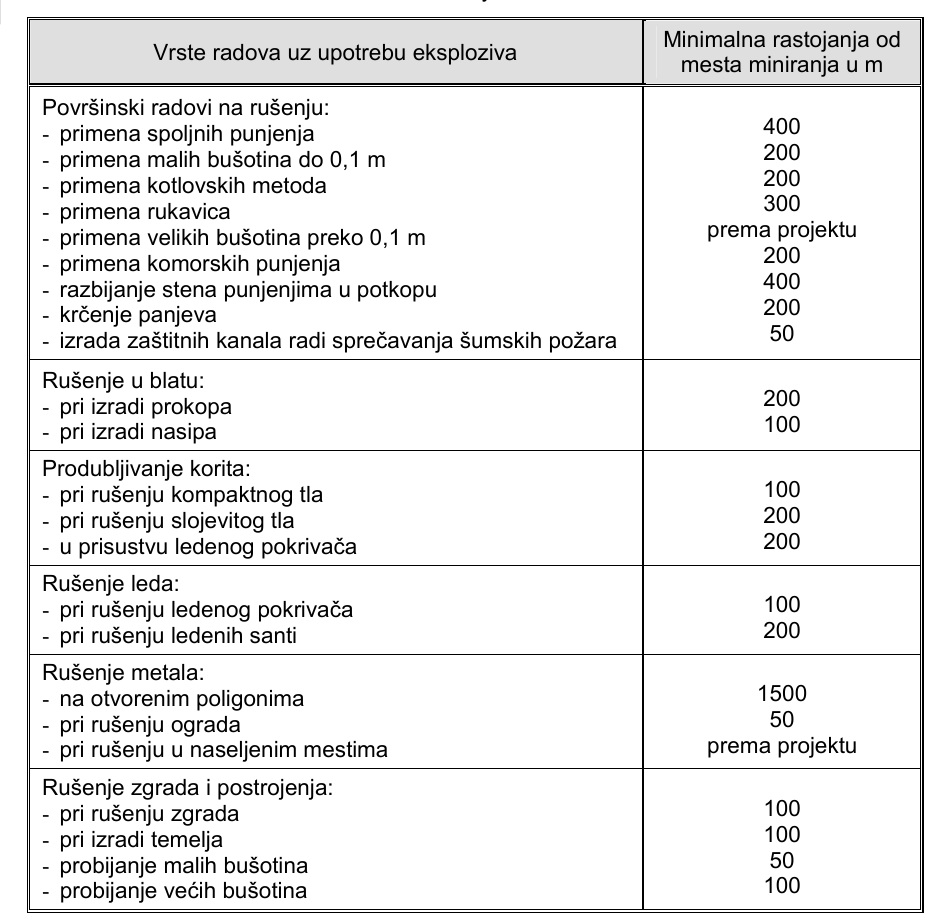
Table 3 – Minimum safety distance in demolition Vrste radova uz upotrebu